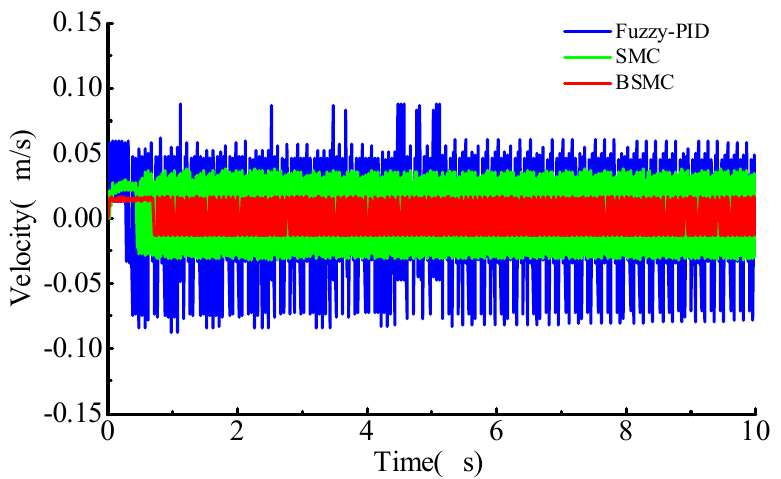
Figure 11. Cylinder speed for sinusoidal command.